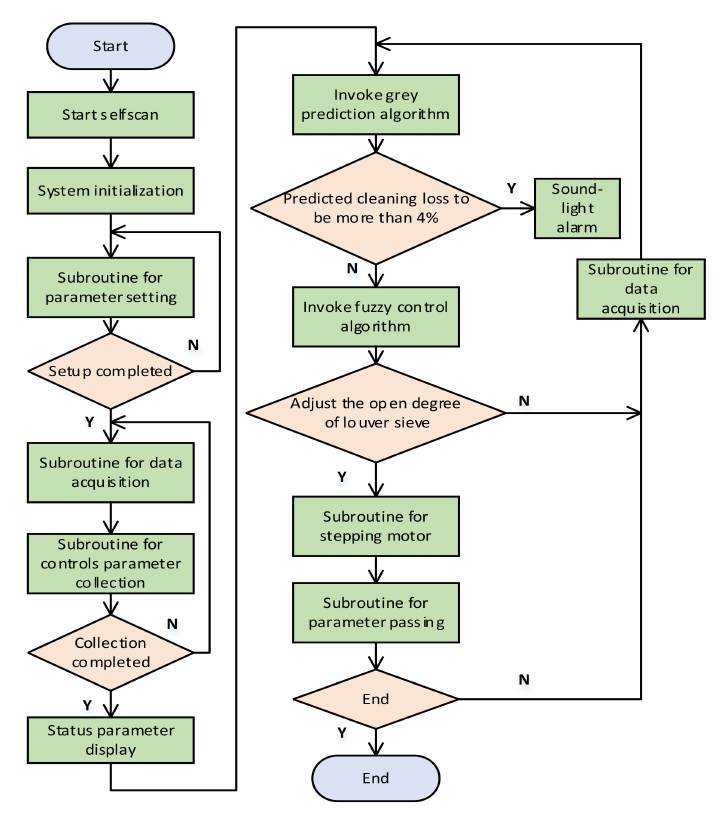
Figure 4. Control system hardware block